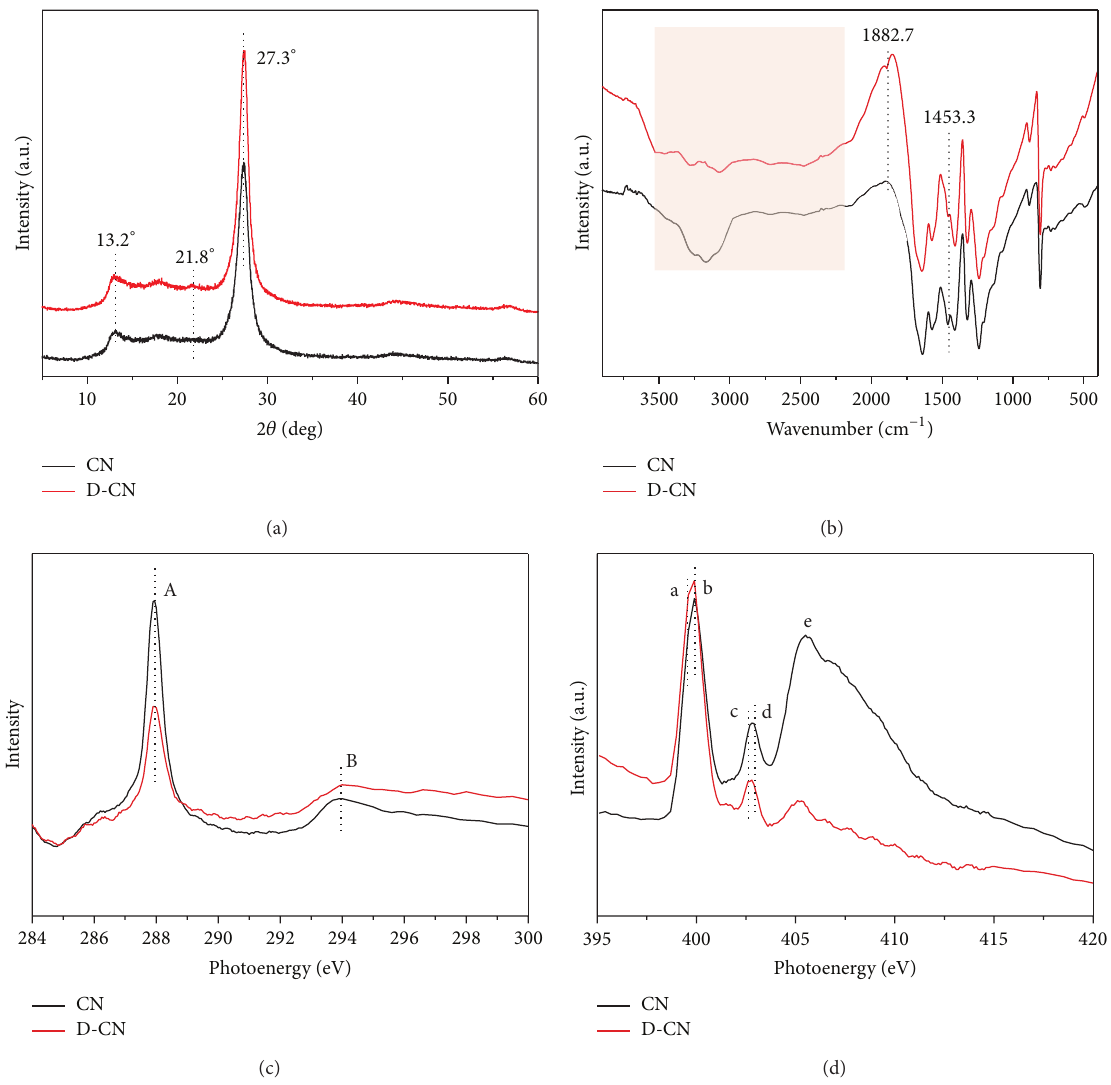
Figure 2: Comparison of XRD patterns (a), FTIR spectra (b), C K-edge (c), and N K-edge (d) XANES spectra of CN and D-CN.